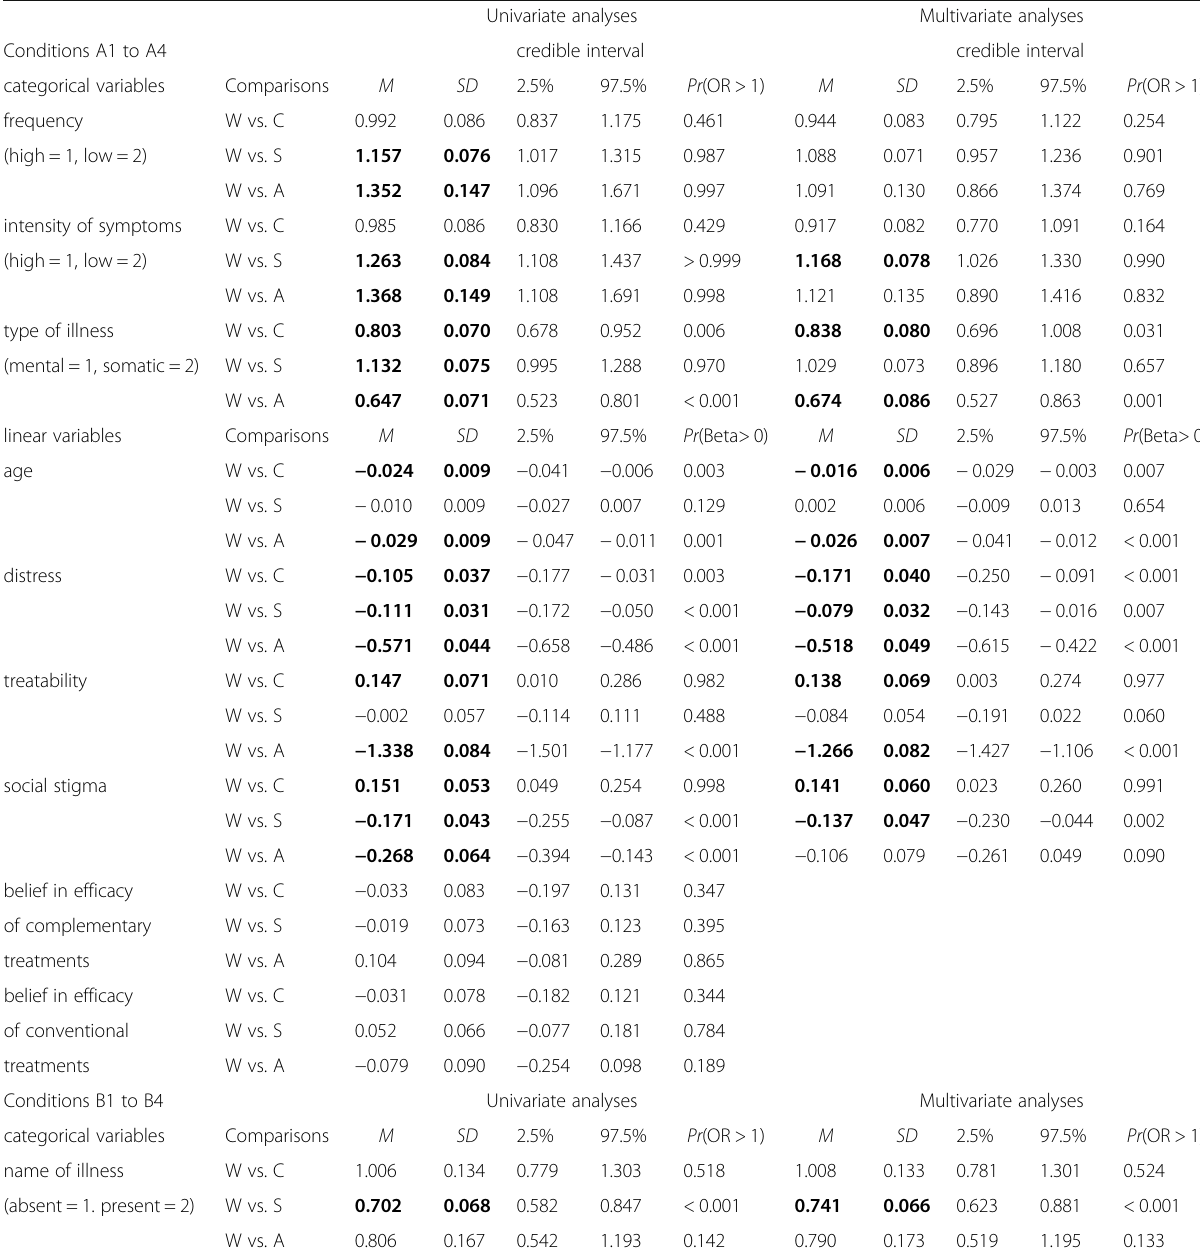
Table 5 Univariate and multivariate analyses of the factors influencing preference for treatment Univariate analyses Multivariate